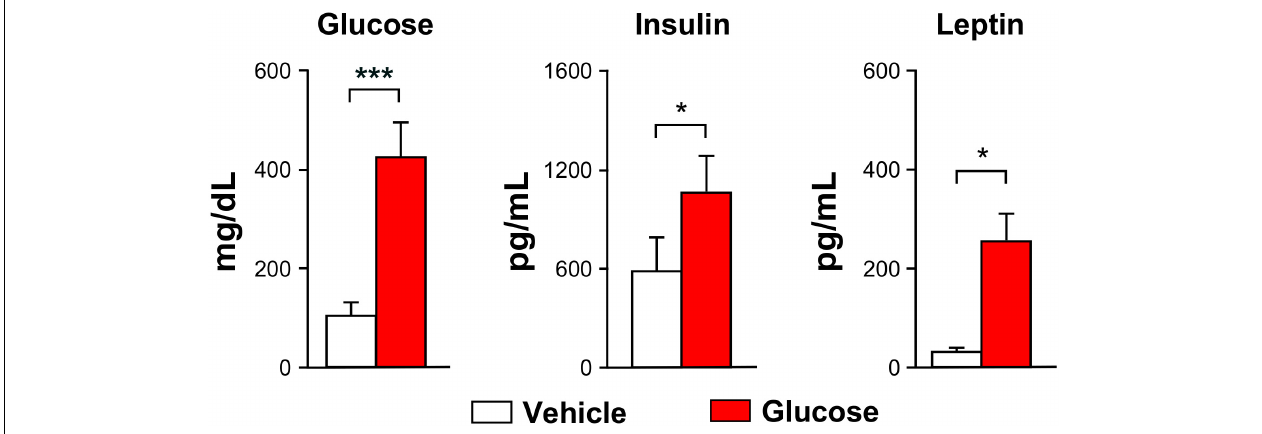
FIGURE 2 | Blood glucose and hormones. Graph bars depicting mean ( ± SEM) values for the vehicle (white) or glucose (red) administered animals. All values were measured after the MRI evaluations ( ∗ p < 0.05, ∗∗∗ p <